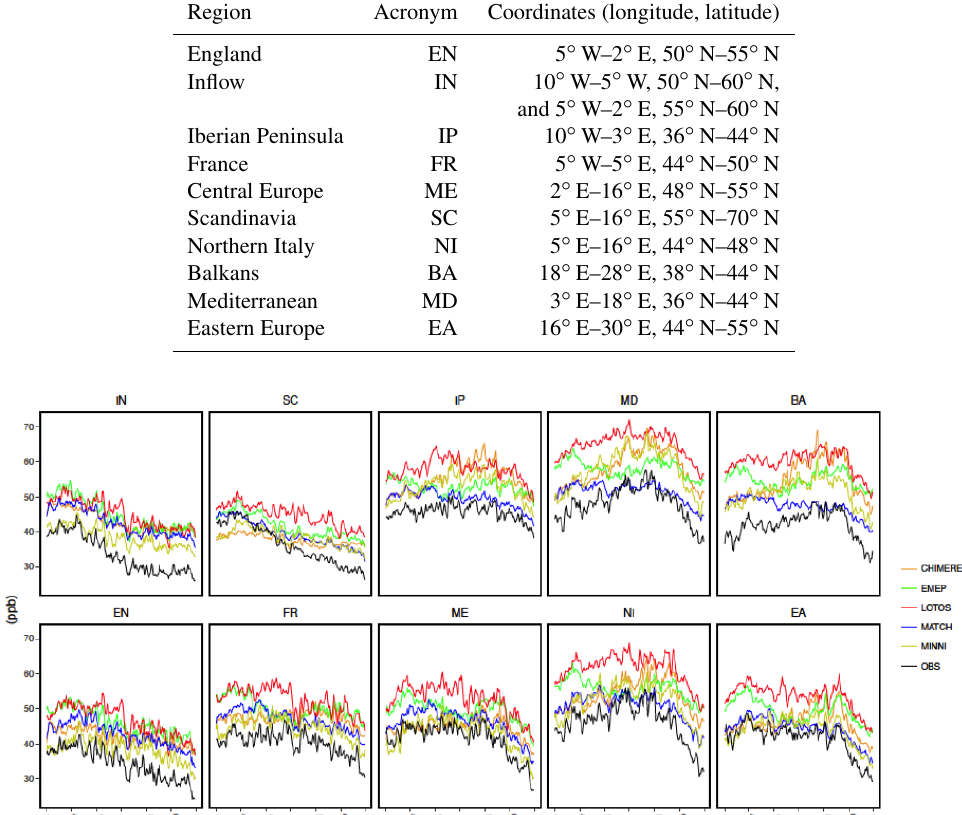
Figure 2. Time series of daily averages of MDA8 O 3 during the ozone season (April–September) for the period of study (2000–2010) at each